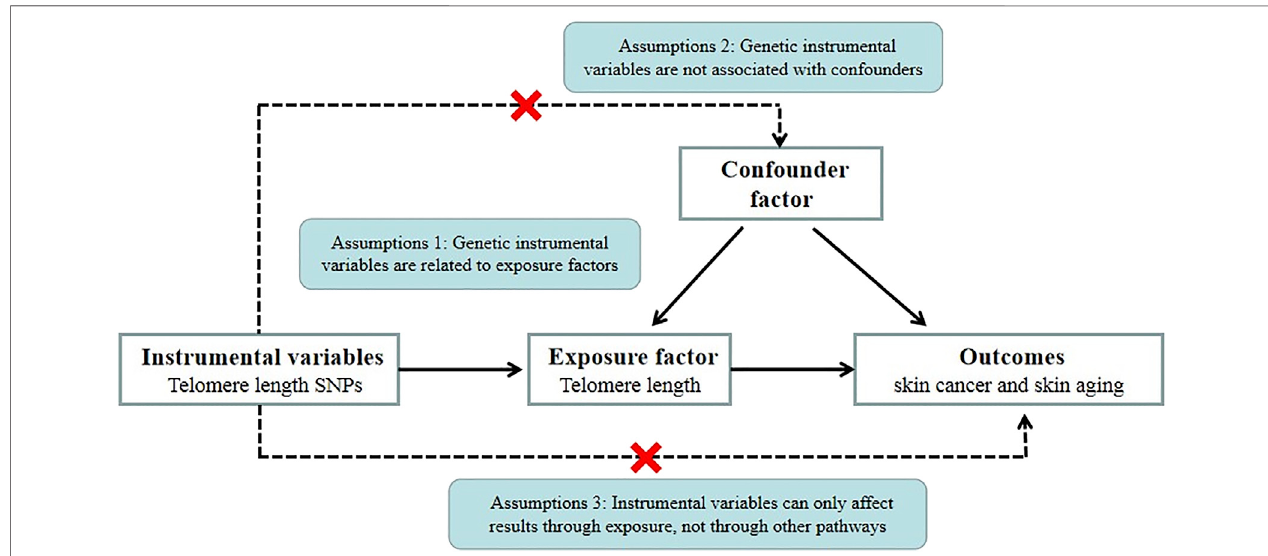
FIGURE 1 | MR basic requirements framework. Two-sample MR studies need to satisfy three assumptions. Assumption 1: Instrumental variables should be associatedwithtelomerelength.Assumption2:Theselectedinstrumentalvariablesshouldbeindependentofconfounders.Assumption3:Instrumentalvariablesshould affect outcomes only through exposure and not through direct